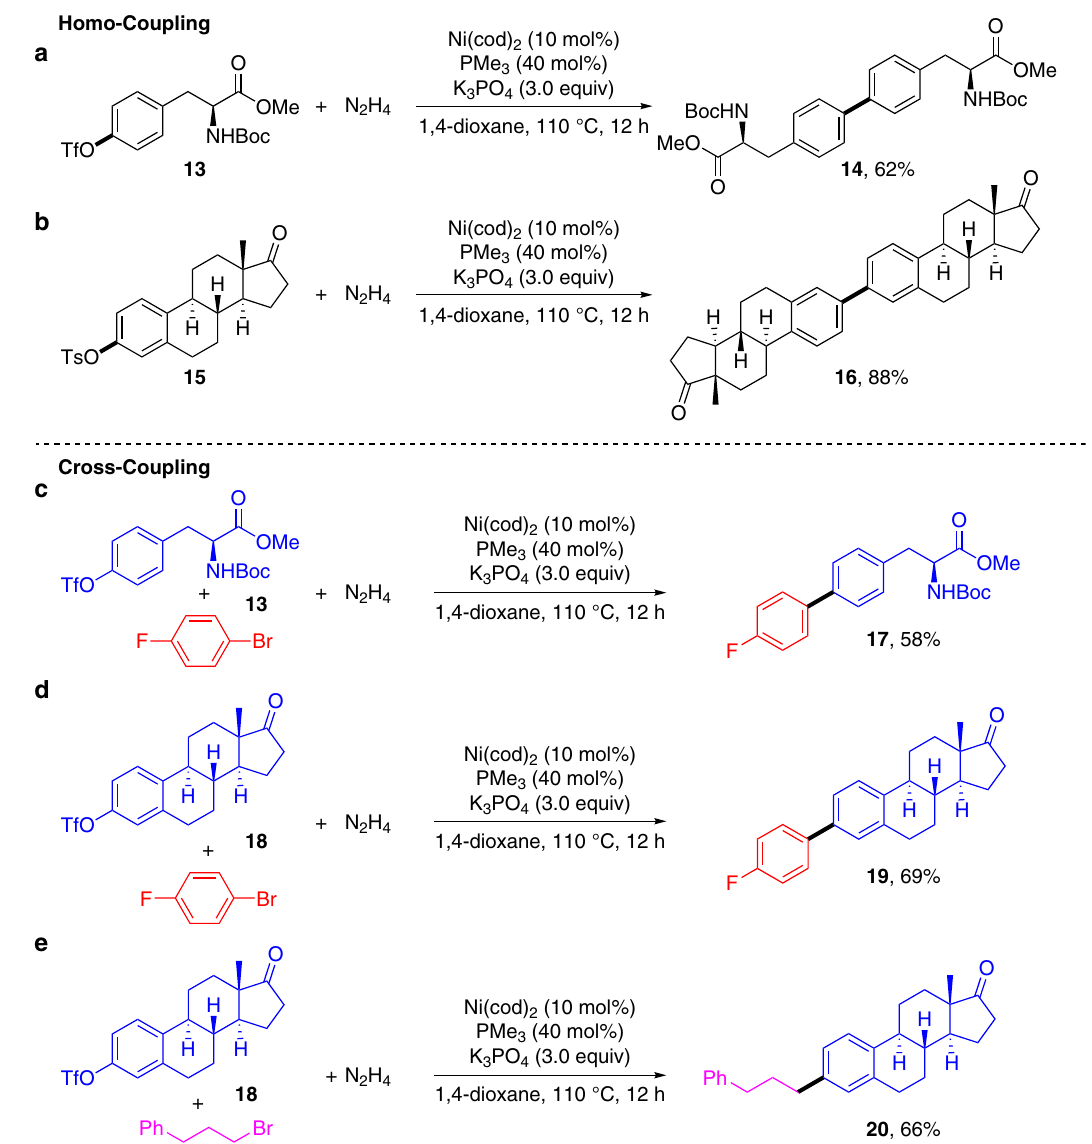
Fig. 8 Applications in the homo- and cross-coupling of bioactive molecules. a Homo-coupling of tyrosine tri fl ate; b Homo-coupling of estrone tosylate; c cross-coupling of tyrosine tri fl ate with 1-bromo-4- fl uorobenzene; d cross- coupling of estrone tosylate with 1-bromo-4- fl uorobenzene; e Cross-coupling of estrone tri fl ate with